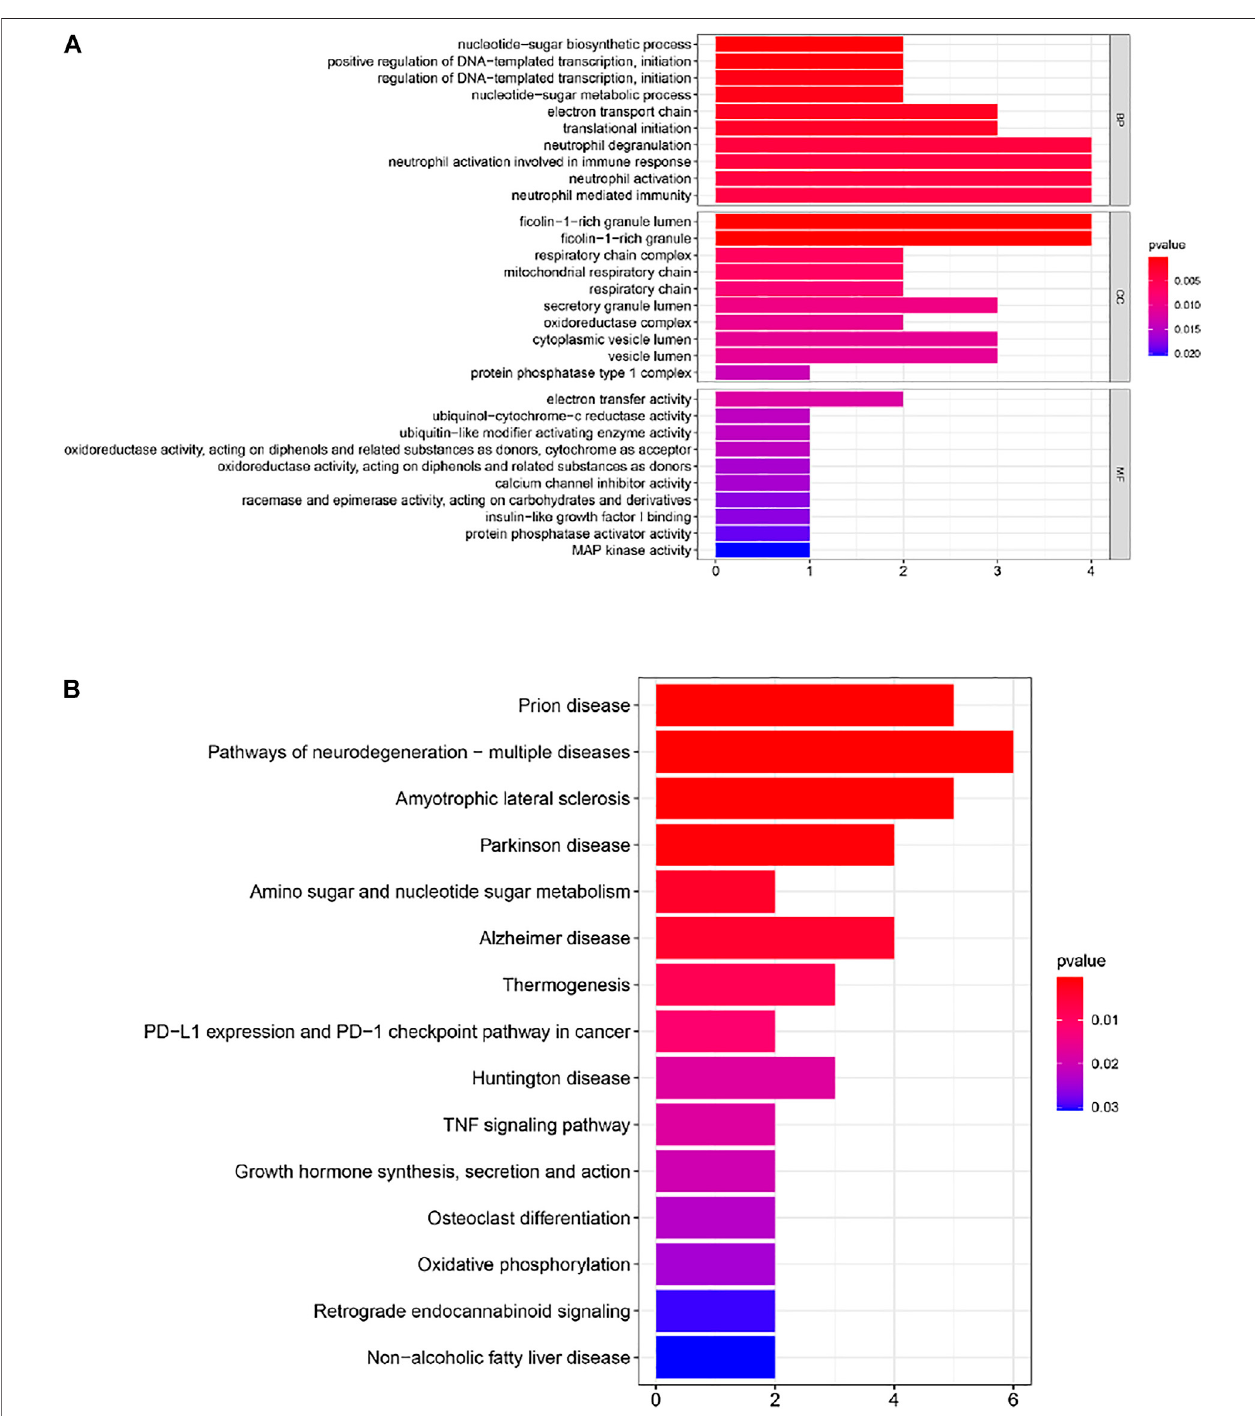
FIGURE 4 | (A) Gene Ontology (GO) enrichment analysis for the 29 genes. (B) Kyoto Encyclopedia of Genes and Genomes (KEGG) enrichment analysis for 29 genes. The color represents the adjusted p -values (BH), and the size of the bars represents the gene number.